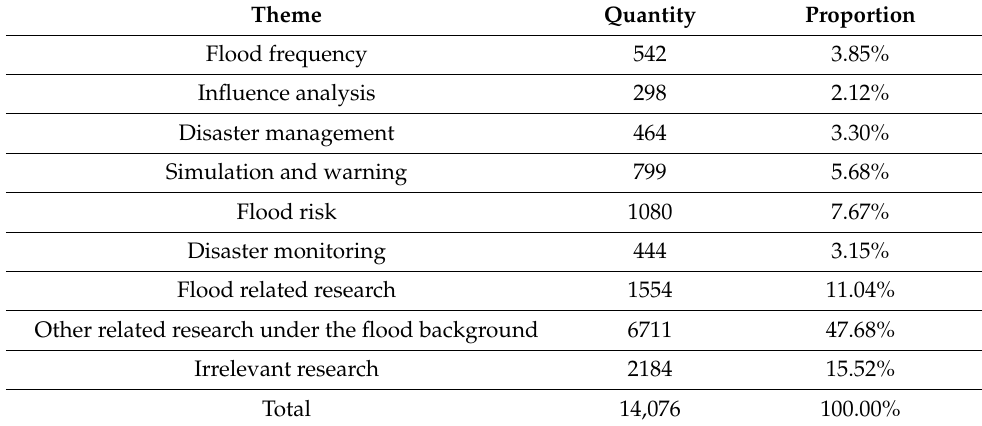
Table 1. Quantitative statistics on literature themes.